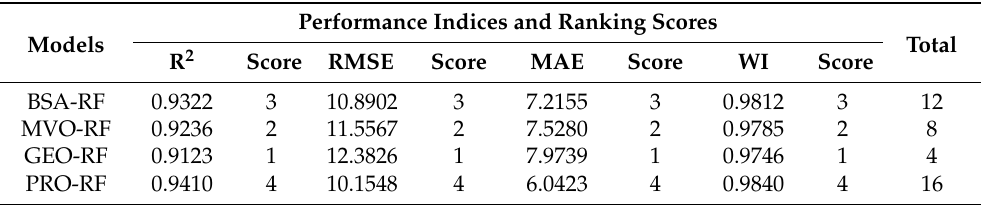
Figure 7. Regression diagrams of the four hybrid RF models using the train set: ( a ) BSA-RF model; Table 4. Performance and ranking results of four hybrid RF models in the testing phase.